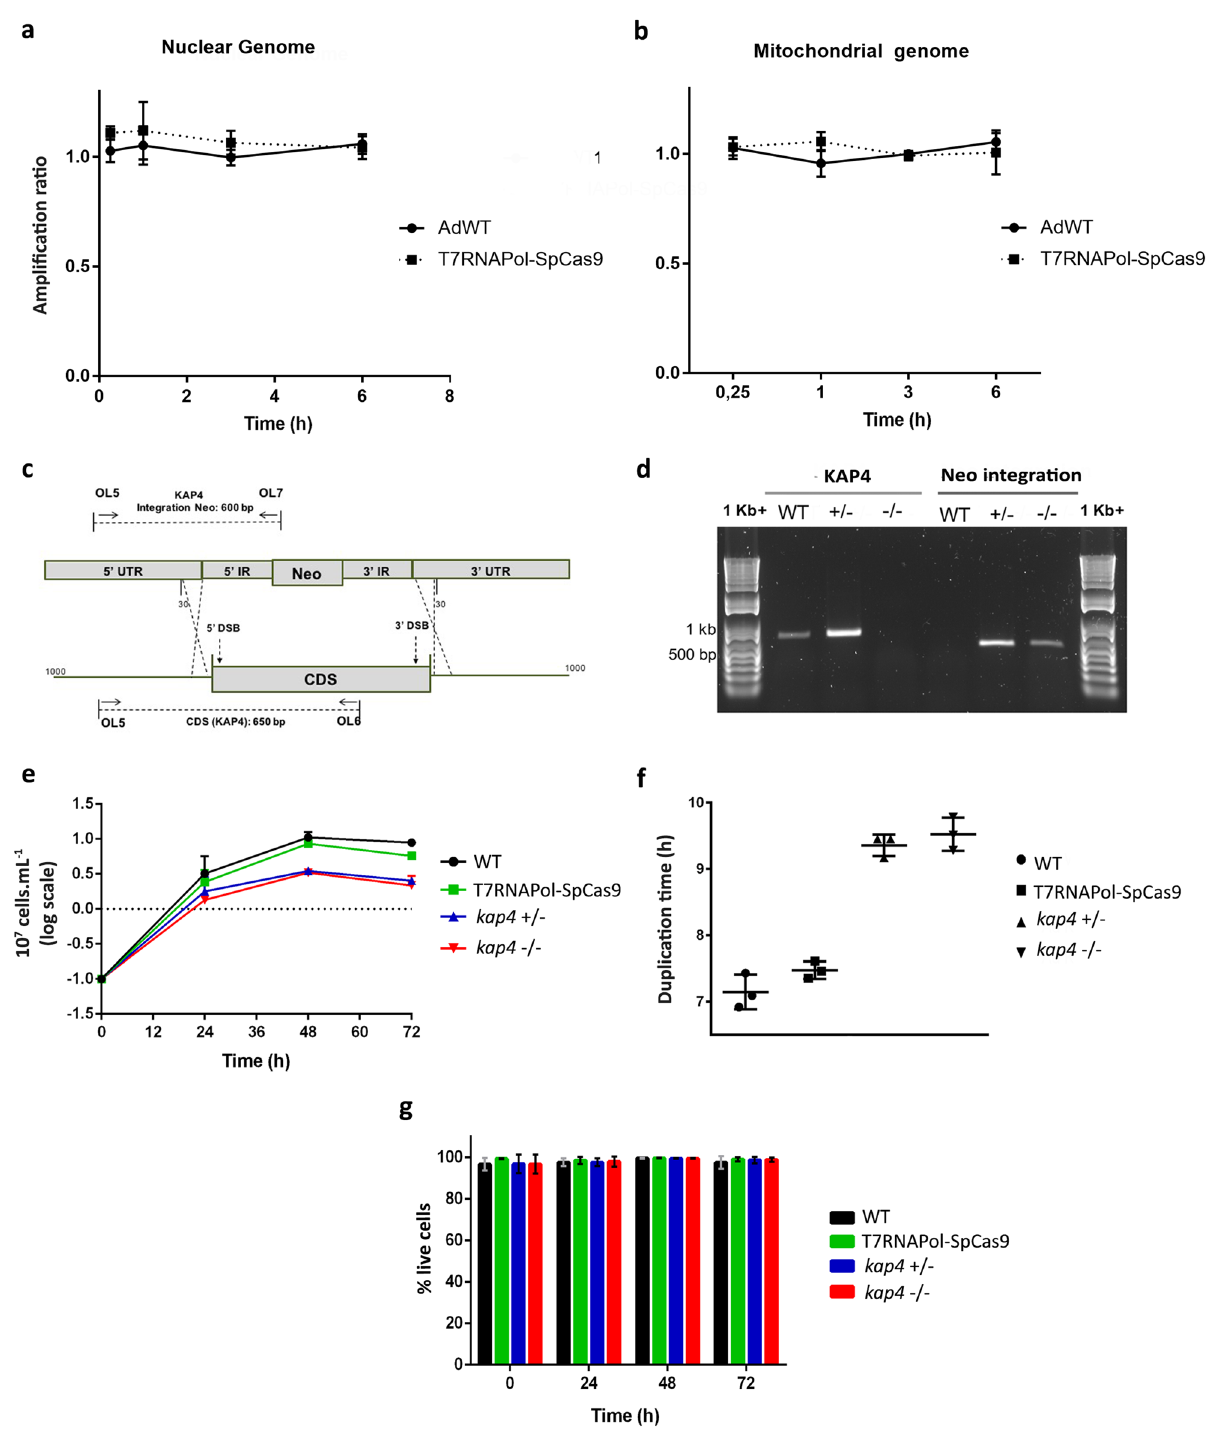
Figure 1. Generation of KAP4 mutants, cell proliferation and viability. qPCR amplification showing that there was no damage to the nuclear ( a ) and mitochondrial ( b ) DNA of the T7RNAPol-SpCas9 cells compared to WT cells. ( c ) Diagram representing the sgRNA PCR transfection that allows for double strain breaks (DSBs) at the 5 ′ and 3 ′ ends of the genes and repair-templates mediated recombination at the UTRs 30 nt upstream and downstream of the CDS. Diagnostic PCR oligonucleotides were designed to amplify the integrated NEO repair template, binding upstream of the open reading frame (OL5) and internally to the NEO gene (OL6), and the presence (WT and +/−) or absence (−/−) of KAP4 (650 bp, OL5 + OL7). ( d ) Diagnostic PCR showing KAP4 gene deletion and Neo selectable marker integration in the A. deanei genome. ( e ) Growth curve for 72 h showed that KAP4 mutants present a reduced proliferation in relation to WT and T7RNAPol-SpCas9 strains. Cell number was plotted on a logarithmic scale, and the presented data are the mean ± s.d. of three independent cell cultures. After 48 h, when cells reached the peak of the exponential phase, a paired T test (p < 0.05) was performed to compare control and mutant cells. ( f ) Duplication time of WT, T7RNAPol-SpCas9 and cells deleted for KAP4 . ( g ) The cell viability was similar among the strains analyzed and maintained even after 72 h of cultivation. The presented data is a mean ± s.d. of three independent cell cultures. WT, wild-type cells, kap4 +⁄− , cells with deletion for one allele, kap4 −⁄− , null